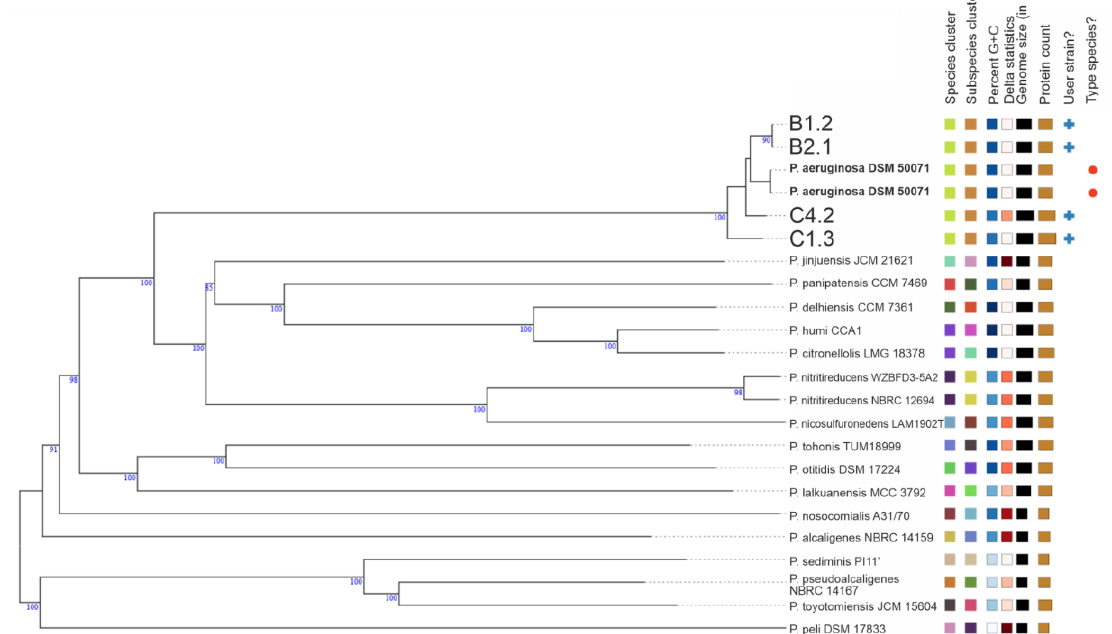
Figure 3. Genome-scale GBDP gene sequence tree. Whole genome sequences were used for additional taxonomic classification of the strains. Phylogenetic genome-scale GBDP tree and 16S rRNA gene sequence tree (Supplementary Figure S2) reveal that the four WM isolates belong to the